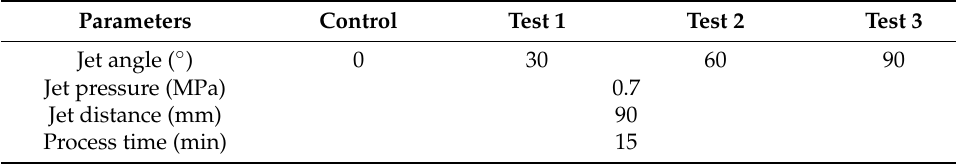
Table 2. Working parameters of the strengthening grinding process.